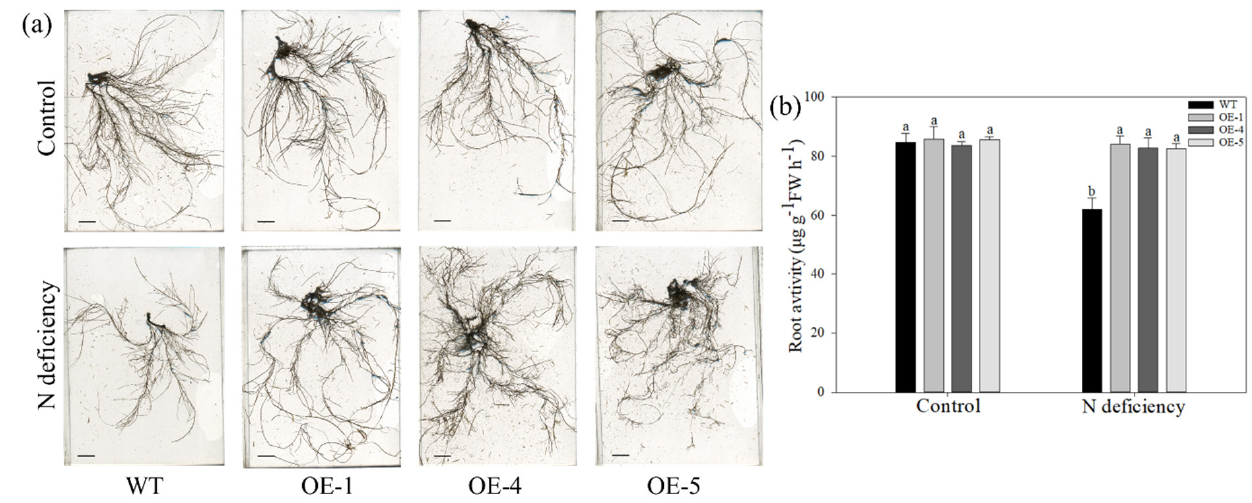
Figure 4. Overexpression of MdATG10 leads to better root growth and activity in apple under nitrogen deficiency stress. ( a ) Root architecture, bars: 1 cm, and ( b ) root activity of WT and transgenic plants with or without treatment. Data are shown as the means of five replicates with SEs. Different letters indicate significant differences between treatments, according to one-way ANOVA followed by Tukey’s multiple range test ( p < 0.05). Table 2. Root scanning analysis of WT and MdATG10 -OE plants after 28 d of nitrogen deficiency treatment.